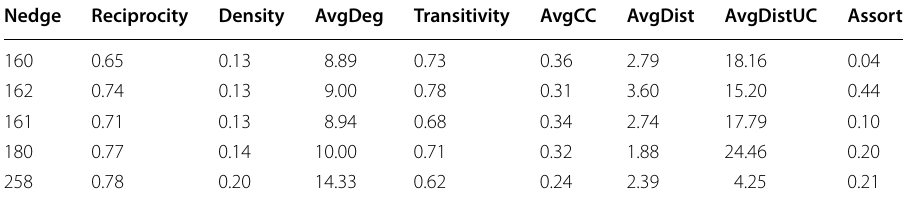
Each row shows the network statistics for tests 1 through 4 and the last row shows the statistics for the aggregate network